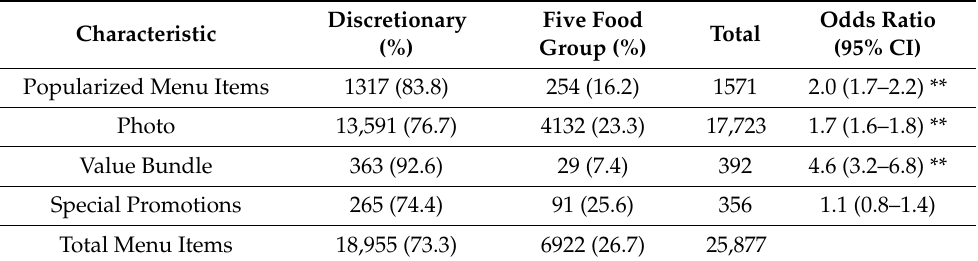
Table 3. The proportion of discretionary categories compared against Five Good Group (FFG) categories within marketing attributes for complete menus 1 . Excludes combination menu item menu